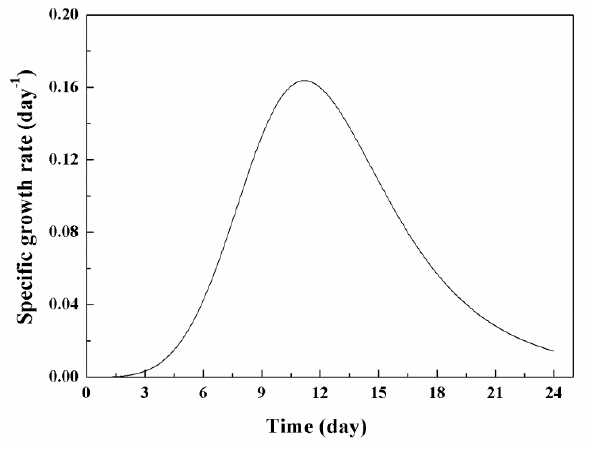
Figure 11. The specific growth rate of Chlorella sp. UJ-3 cells at 20 mg/L of NPs.